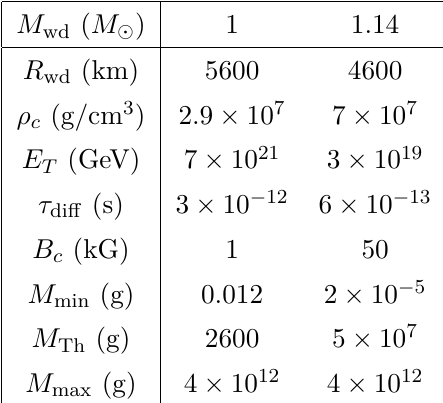
Table 1 . Above are the relevant properties of the WDs used to derive bounds in this work. The radius is R wd , ρ c is the density at the core, E T is the threshold energy needed to initiate runaway fusion, τ diff is the diffusion time, and B c is the estimated magnetic field at the core. The EMBH masses M min , M Th , and M max are the minimum mass needed to trigger runaway fusion, the threshold mass required to overcome the WD core magnetic field, and the maximum mass that can sink to the core in less than a Gyr, respectively. The first column is for generic non-magnetic 1 M (cid:12) CO WDs and the second is for WD J0551+4135. The radii, densities, and diffusion times are derived using WD profiles from ref.